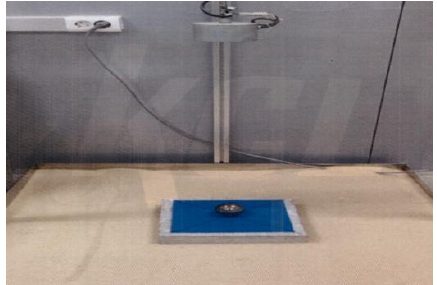
Figure 3. Impact resistance test apparatus.